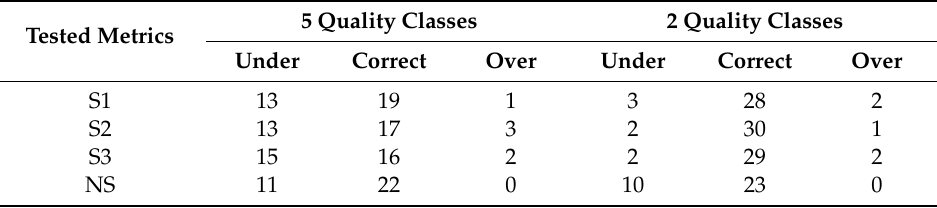
Table 8. Comparison of quality classes, between primary and audited analyses of 33 samples analyzed by the volunteers for the tested metrics (NS, S1, S2, S3). Underevaluation occurs when the class quality of the primary analysis is lower than the audited analysis; an overevaluation occurs in the opposite case. When both classifications match, it is considered as correct. Three samples were not included due to deficient preservation of the material sent to the auditors. Tested Metrics